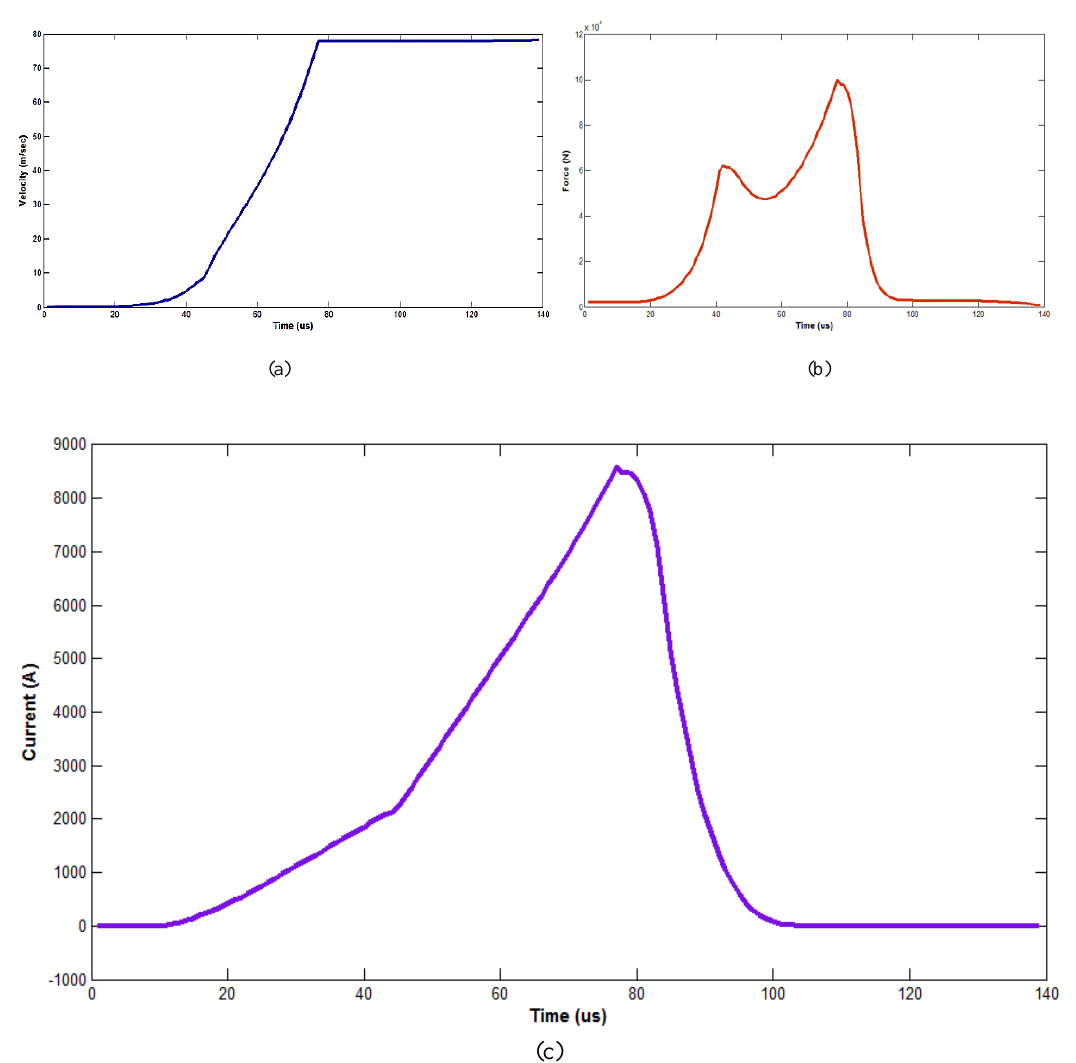
Figure 9. Performance characteristics of MFEML (a) Velocity, (b) Force and (c) Current